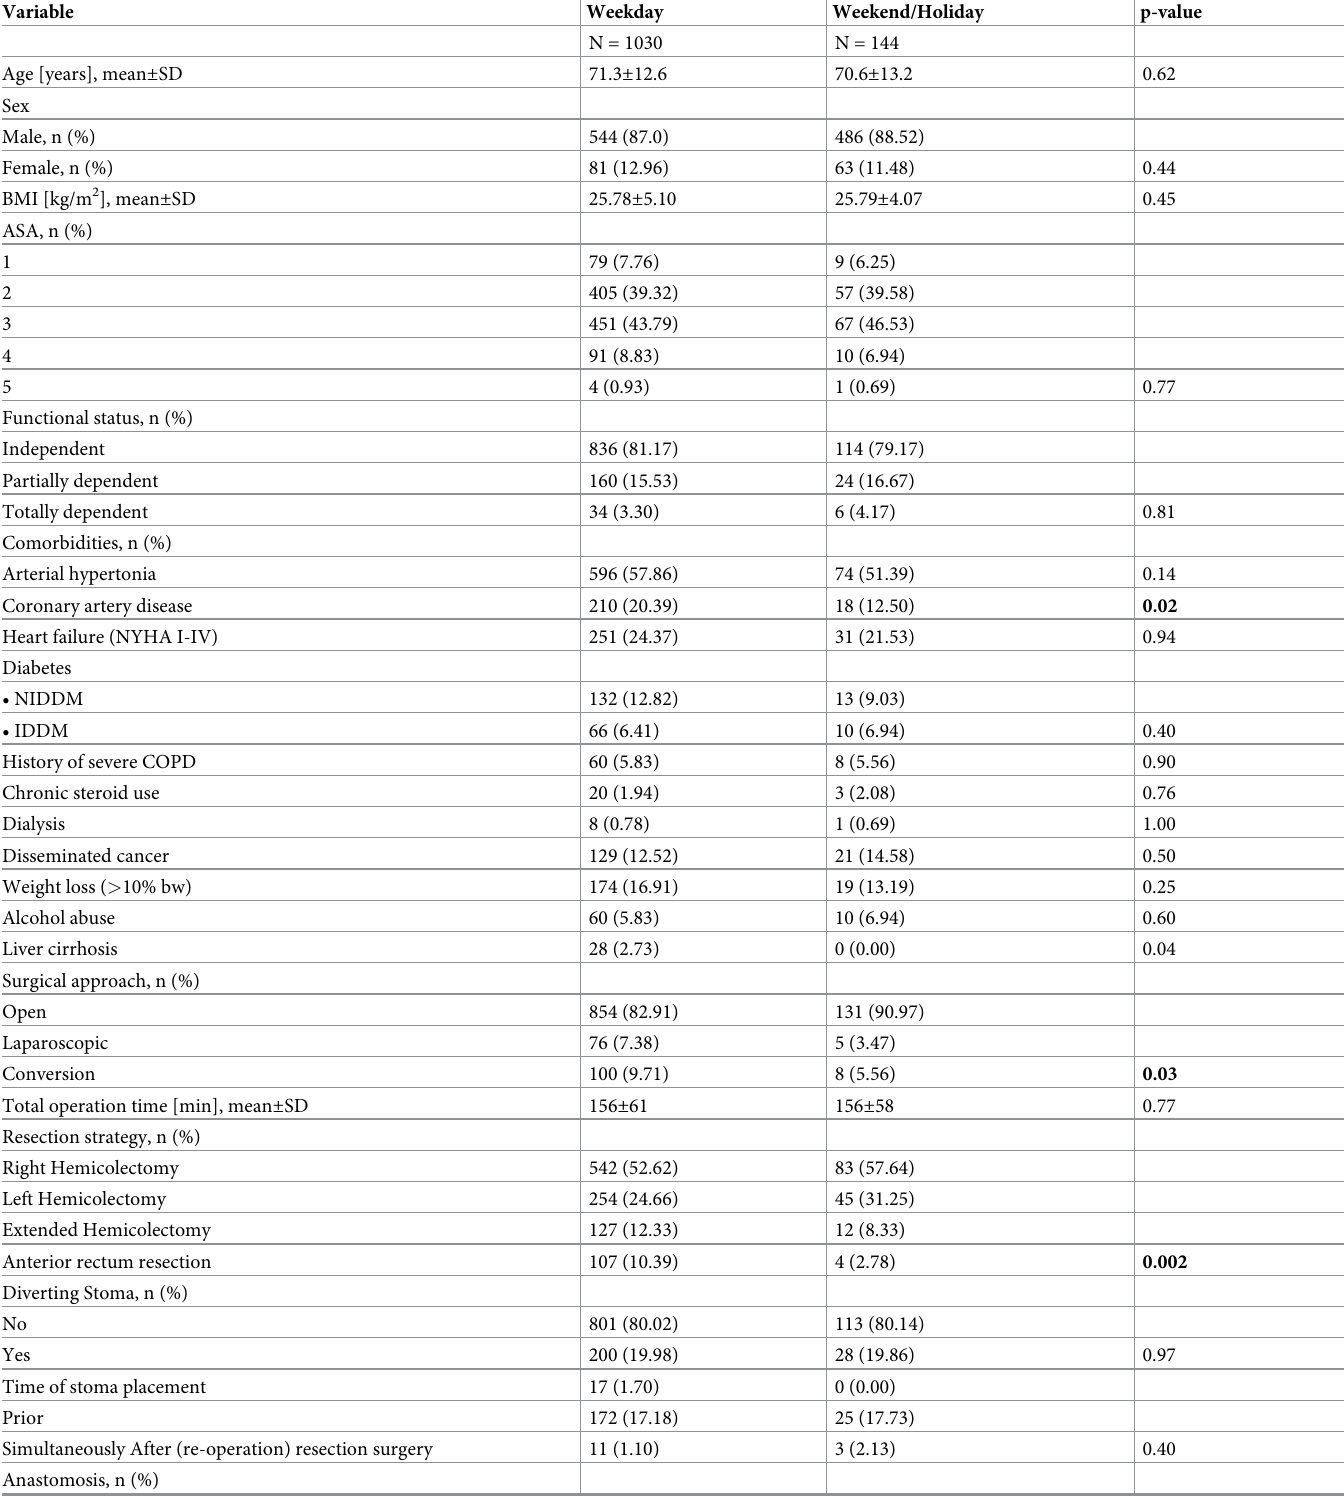
Table 1. Patient characteristics by weekday of